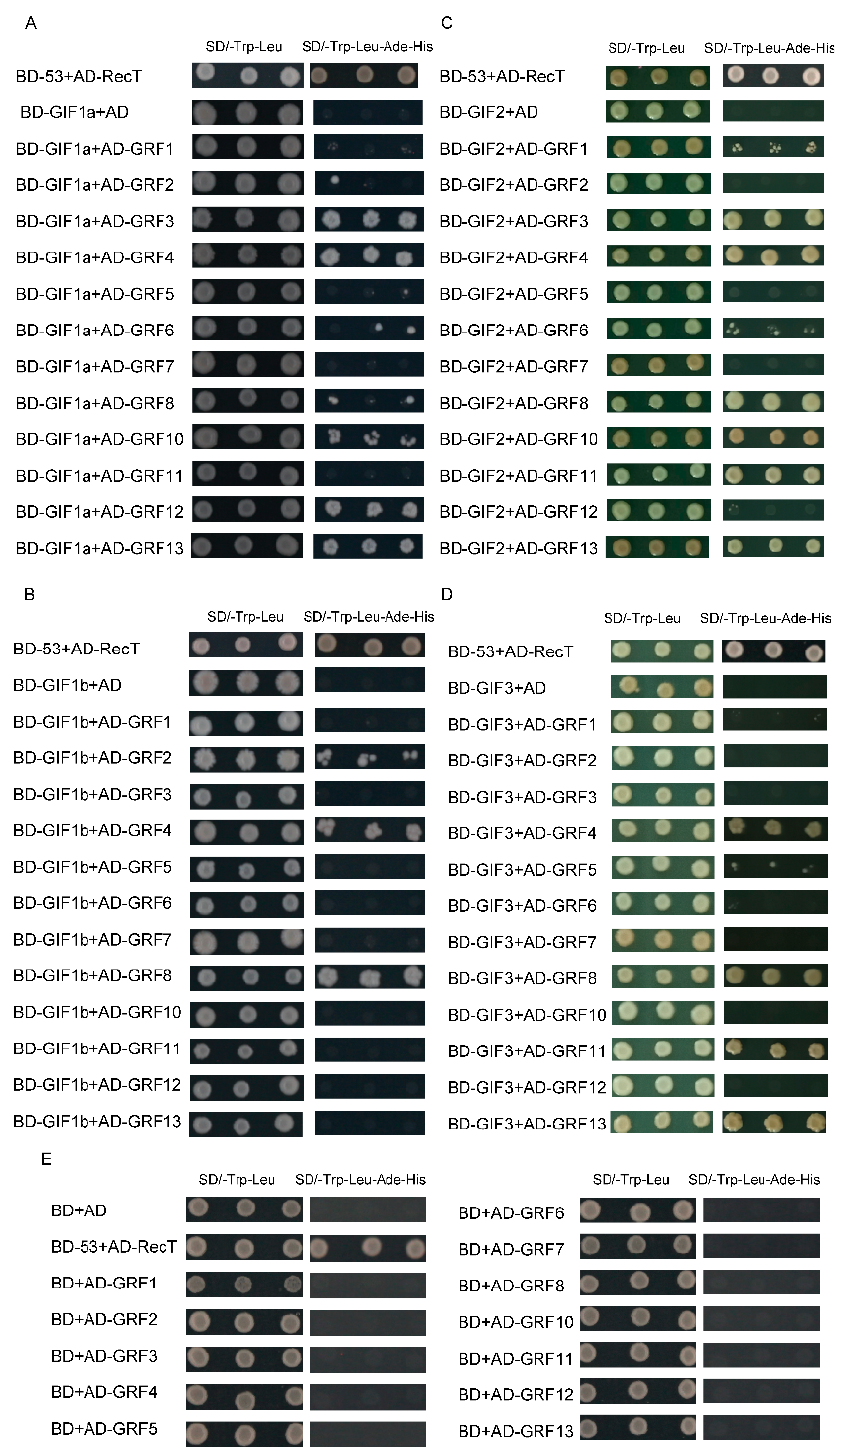
Figure 7. Interactions between GIF proteins and growth-regulating factors (GRF) proteins in a yeast two-hybrid assay. ( A ) GIF1a interacted with GRFs; ( B ) GIF1b interacted with GRFs; ( C ) GIF2 interacted with GRFs; ( D ) GIF3 interacted with GRFs; ( E ) the negative controls of GRFs. GIF proteins and GRF proteins were used as a bait and a prey, respectively, in di ff erent combinations. SD / -Trp-Leu was an SD medium lacking leucine and tryptophan. SD / -Trp-Leu-His-Ade was an SD medium lacking